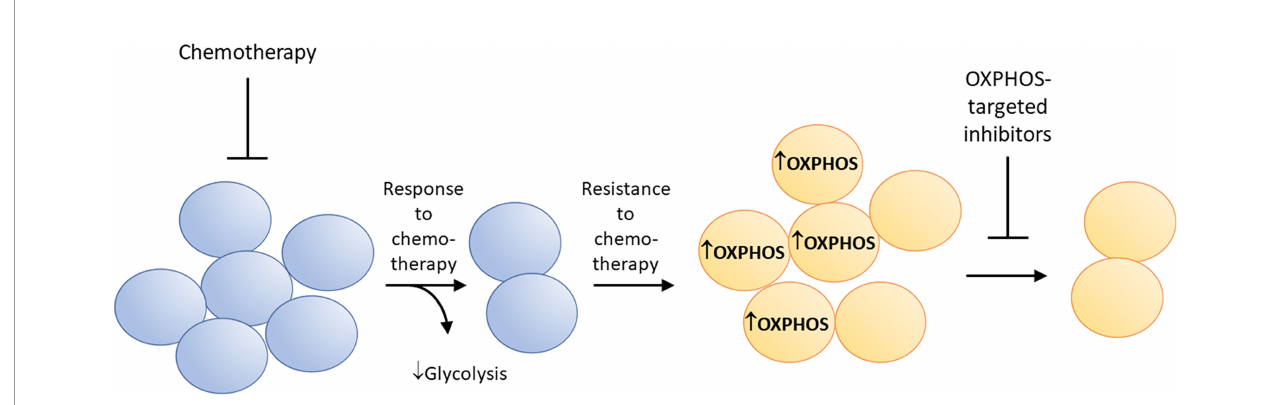
FIGURE 6 | Metabolic reprogramming from glycolysis to enhanced OXPHOS occurs in drug-resistant cancer cells. This characteristic makes these cells more vulnerable to mitochondria-targeted OXPHOS